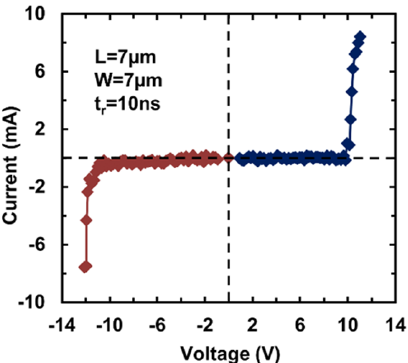
Figure 10. A sample gNEMS switch shows the I–V characteristics of dual-directional ESD under TLP